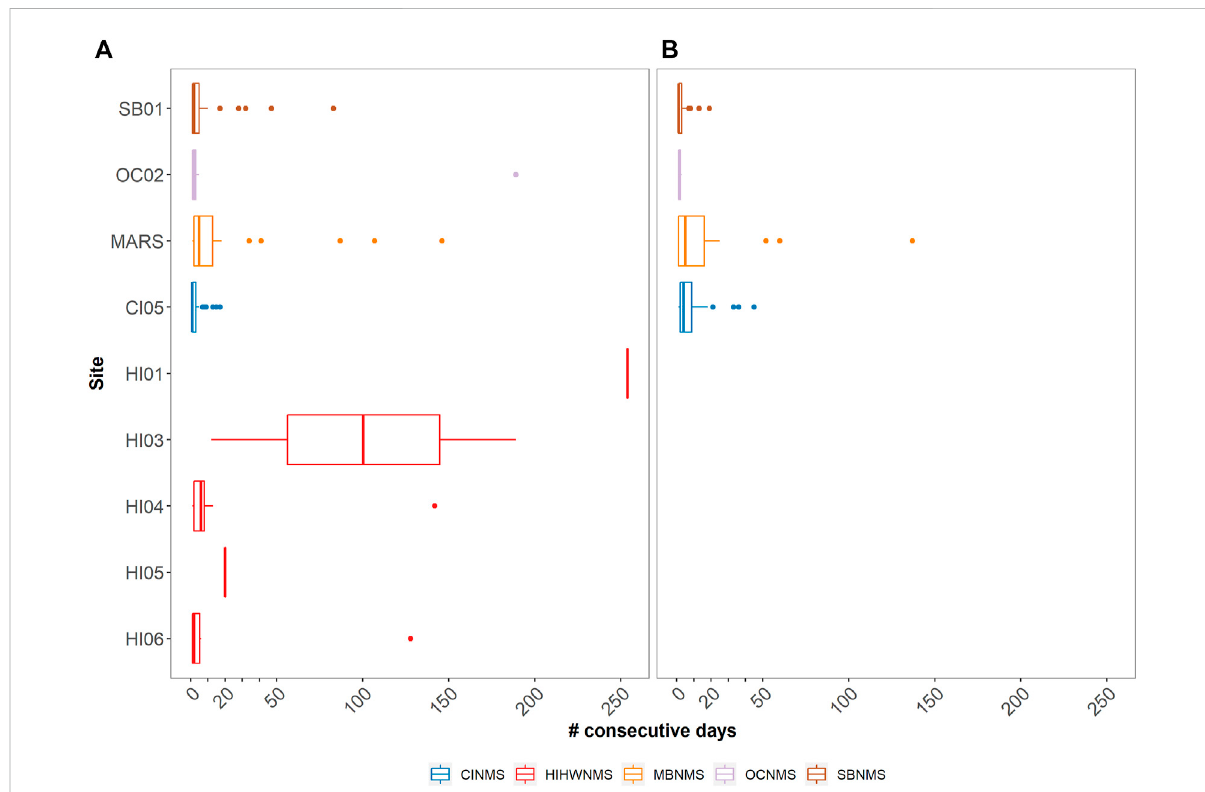
FIGURE 3 Boxplotsshowingthemedianandquartilevaluesofacousticpresenceasthenumberofconsecutivedaystheyweredetectedineachofthe fi ve sanctuariesanalyzed(StellwagenBankNMS[SBNMS]=SB01,OlympicCoastNMS[OCNMS]=OC02,MontereyBayNMS[MBNMS]=MARS,Channel IslandsNMS[CINMS]=CI05,HawaiianIslandsHumpbackWhaleNMS[HIHWNMS]=HI01,HI03,HI04,HI05,HI06)forhumpback (A) and fi nwhale (B)